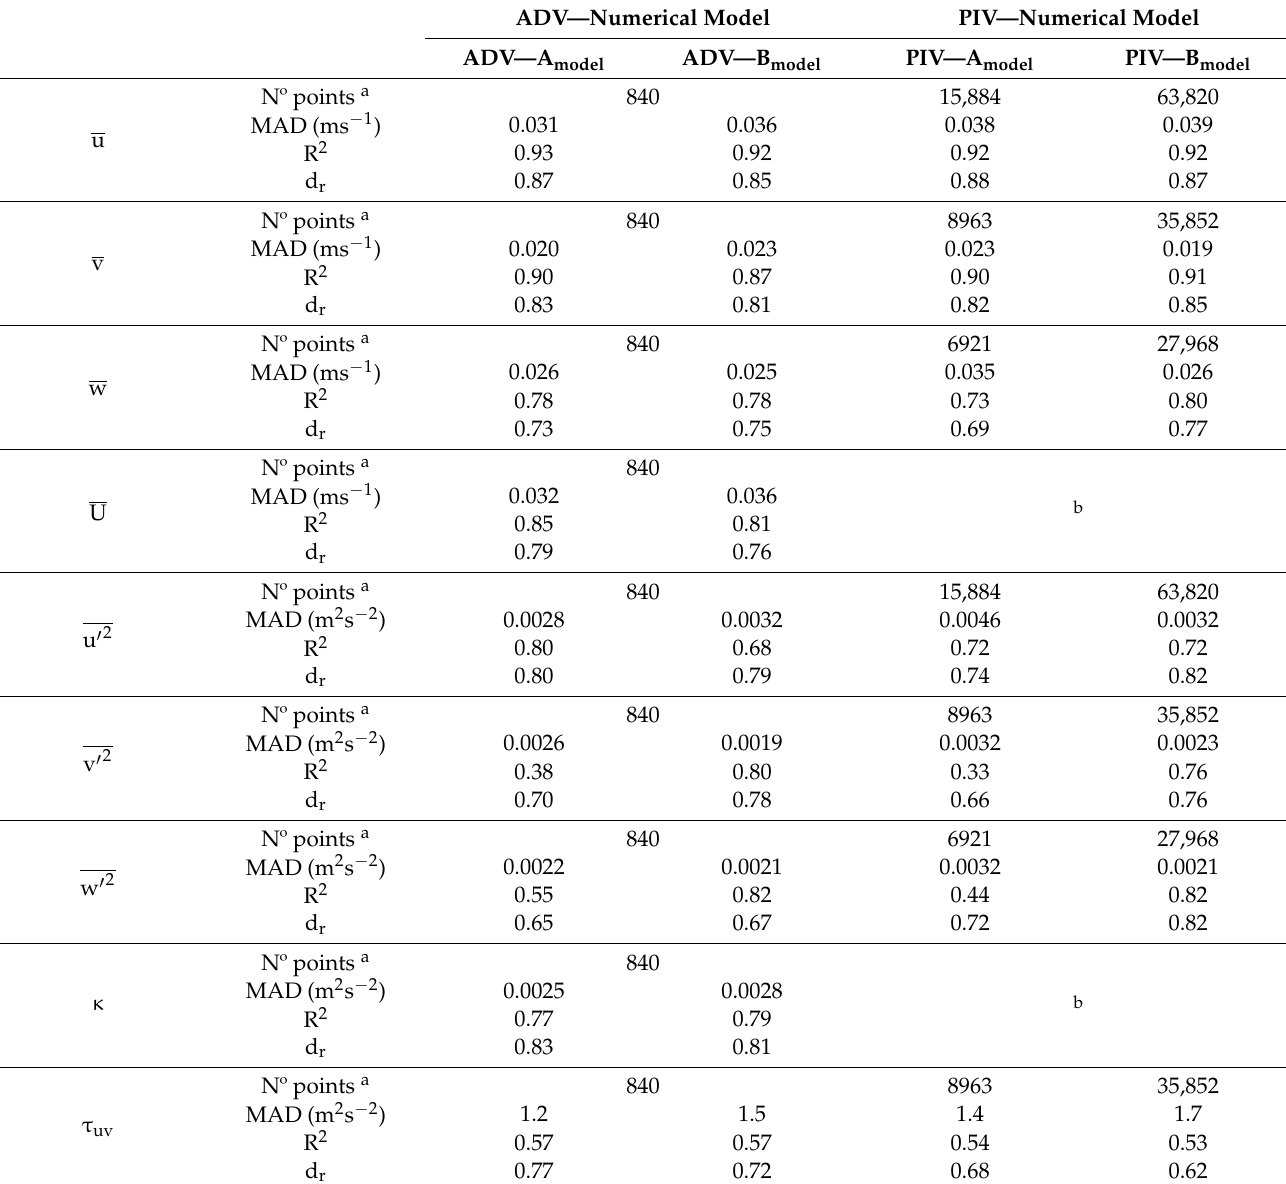
Table 3. Comparison between numerical model results and ADV and particle image velocimetry (PIV)